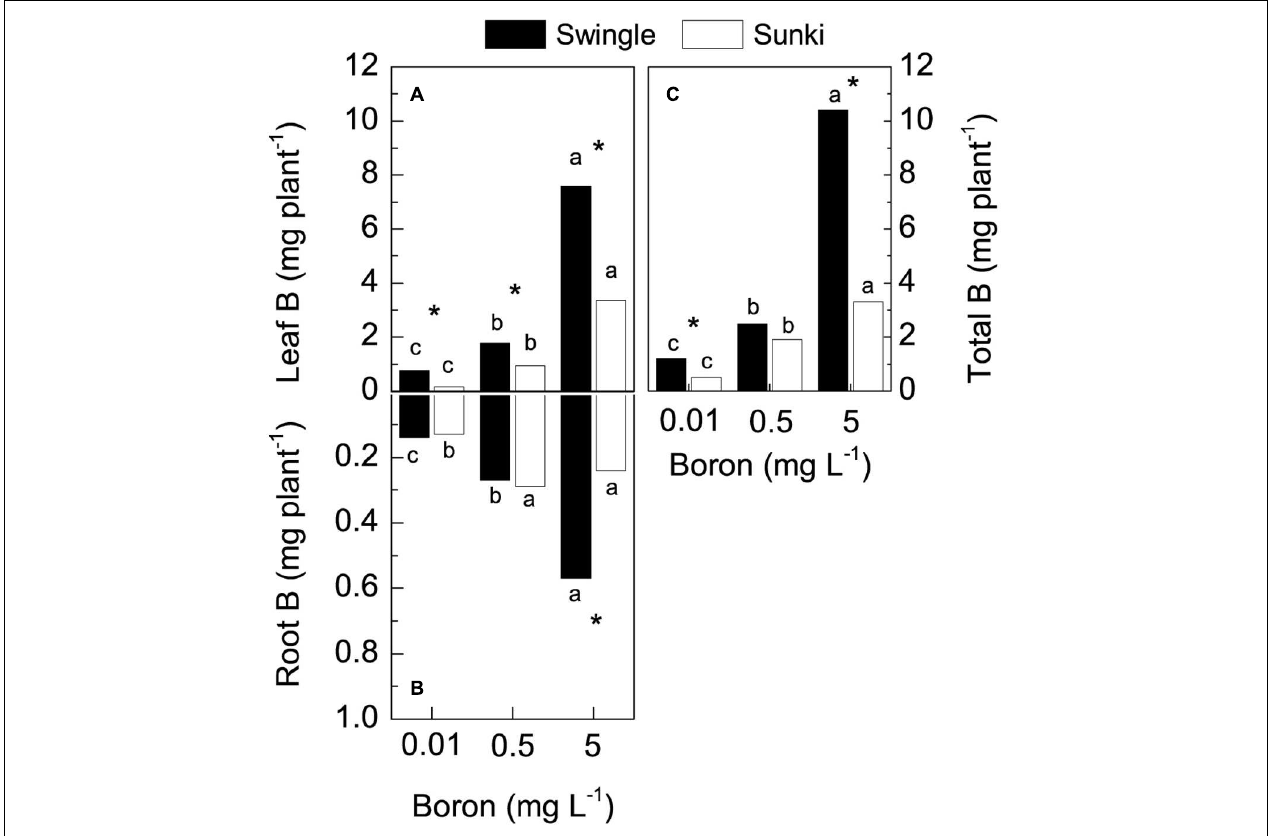
FIGURE 3 | Boron accumulation in leaves (A), roots (B), and whole plant (C) of sweet orange trees grafted on Swingle or Sunki rootstocks grown in nutrient solution with varying concentrations of boron for 130 days. Asterisks compare rootstocks in a given boron concentration, whereas lowercase letters indicate significant difference between boron concentrations in a given rootstock (Tukey test at p <